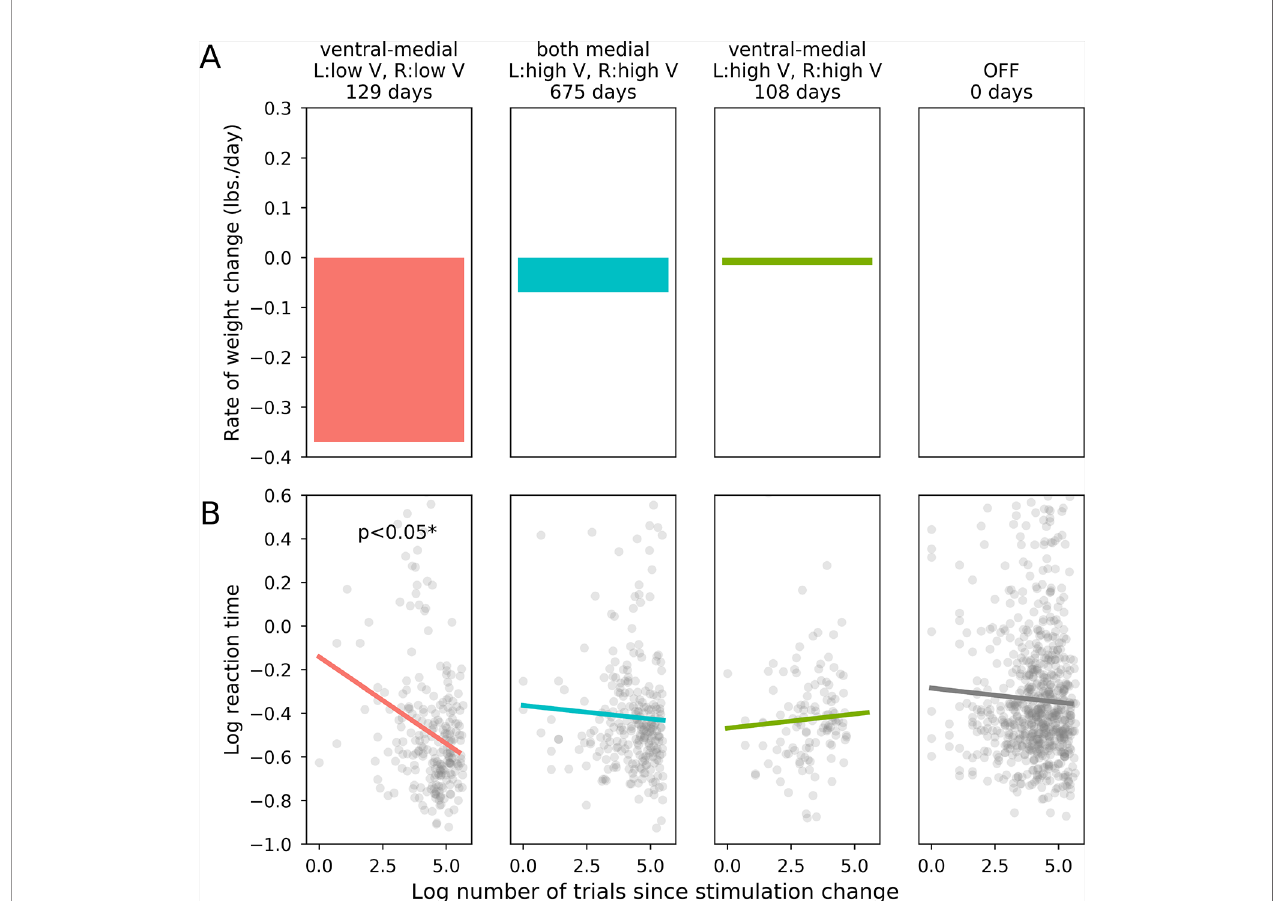
FIGURE 2 | Effects of stimulation on weight loss and fl anker performance. (A) : Rate of long term weight loss (mean lbs. per day) for each set of stimulation parameters. (B) : The horizontal axis is the log-transformed trial number, which is an indicator of how much time had passed since the relevant stimulation parameter set became active. The vertical axis is the patient ’ s log-transformed reaction time on each trial, which was our dependent variable metric for the patient ’ s performance on the fl anker